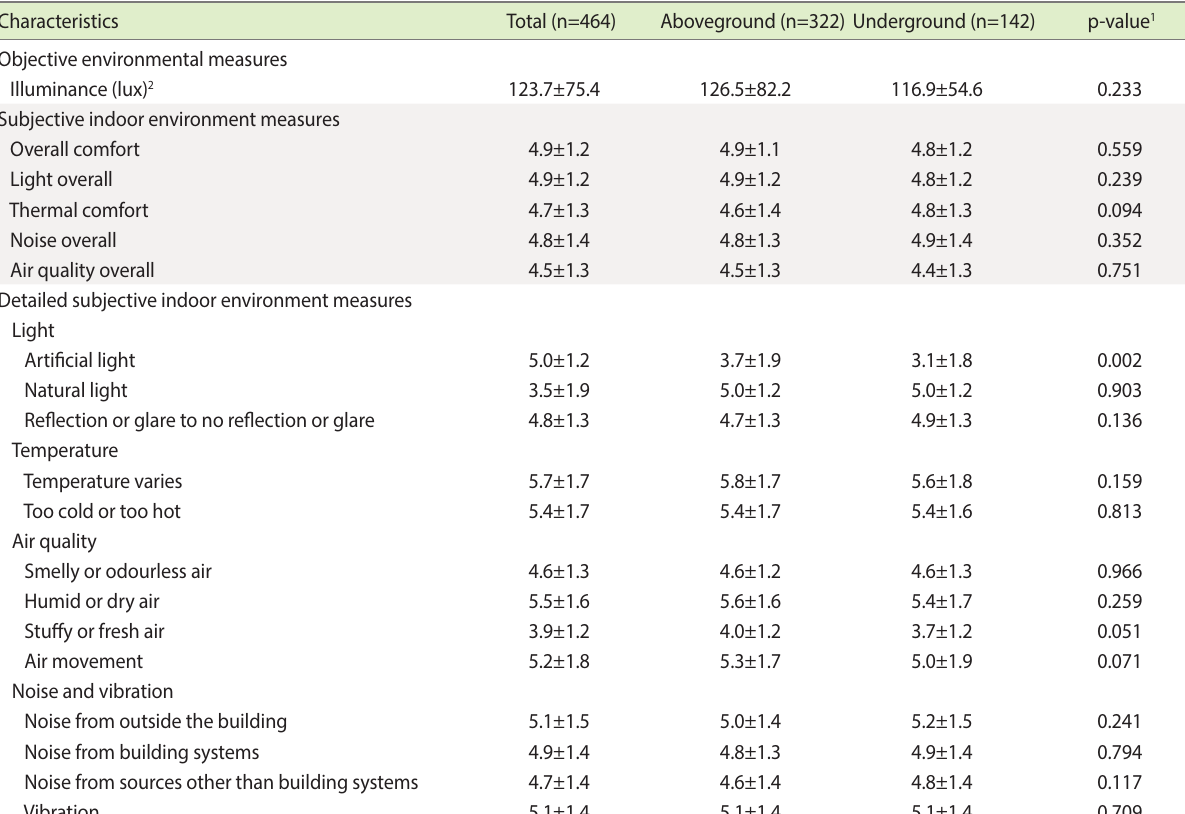
Table 6. Indoor environmental parameters of the study cohort at baseline